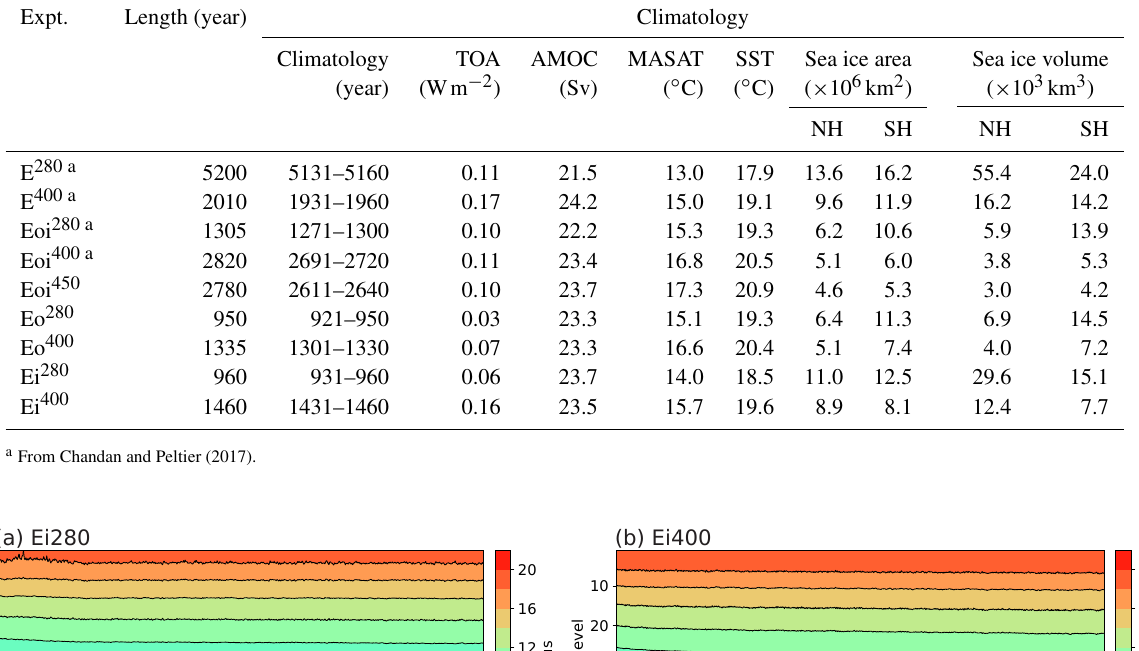
Table 2. Climatology-based diagnostics for our PlioMIP2 experiments. Expt.